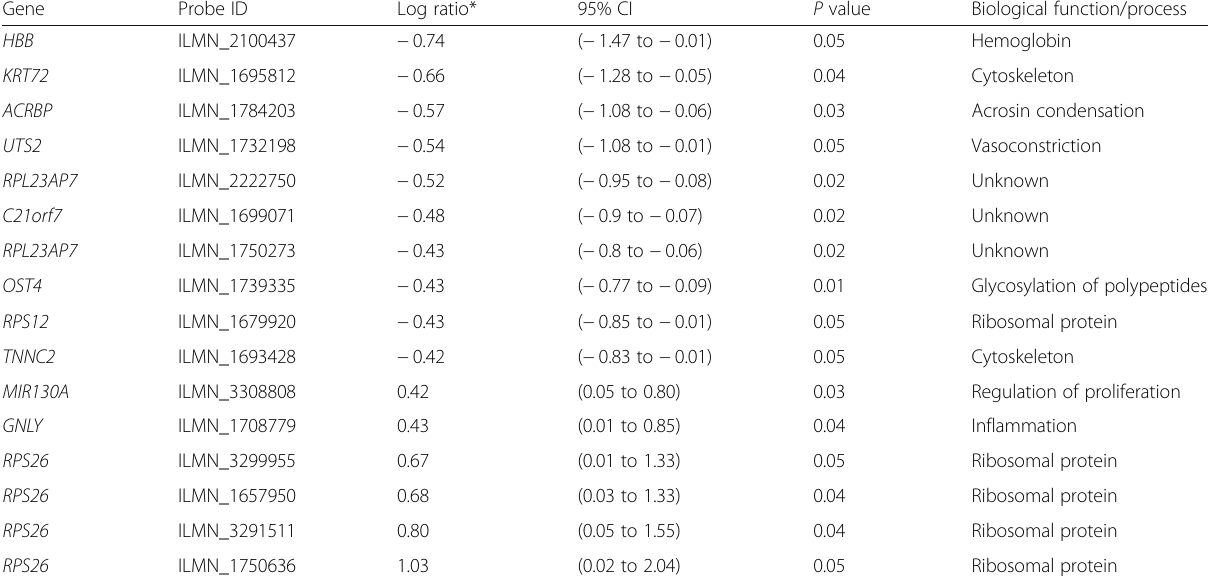
*mRNA levels in responders relative to non-responders adjusted for age and gender